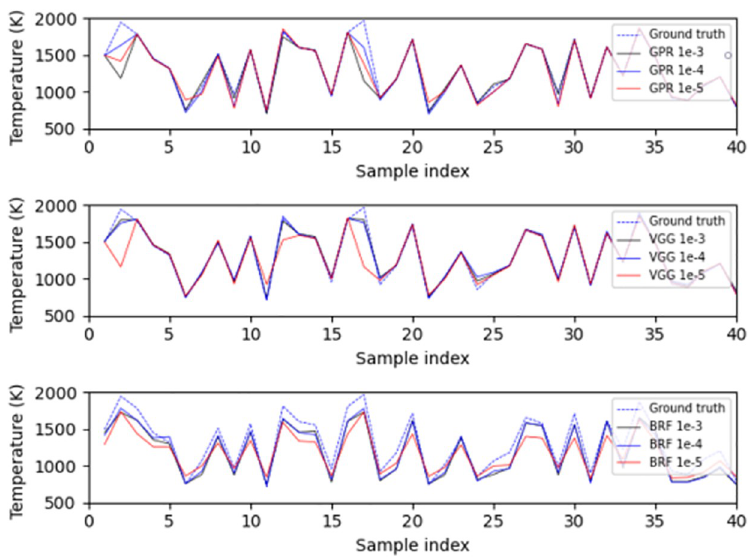
Fig 11. Examples of generalization performance of the retrained models on uniform-profile